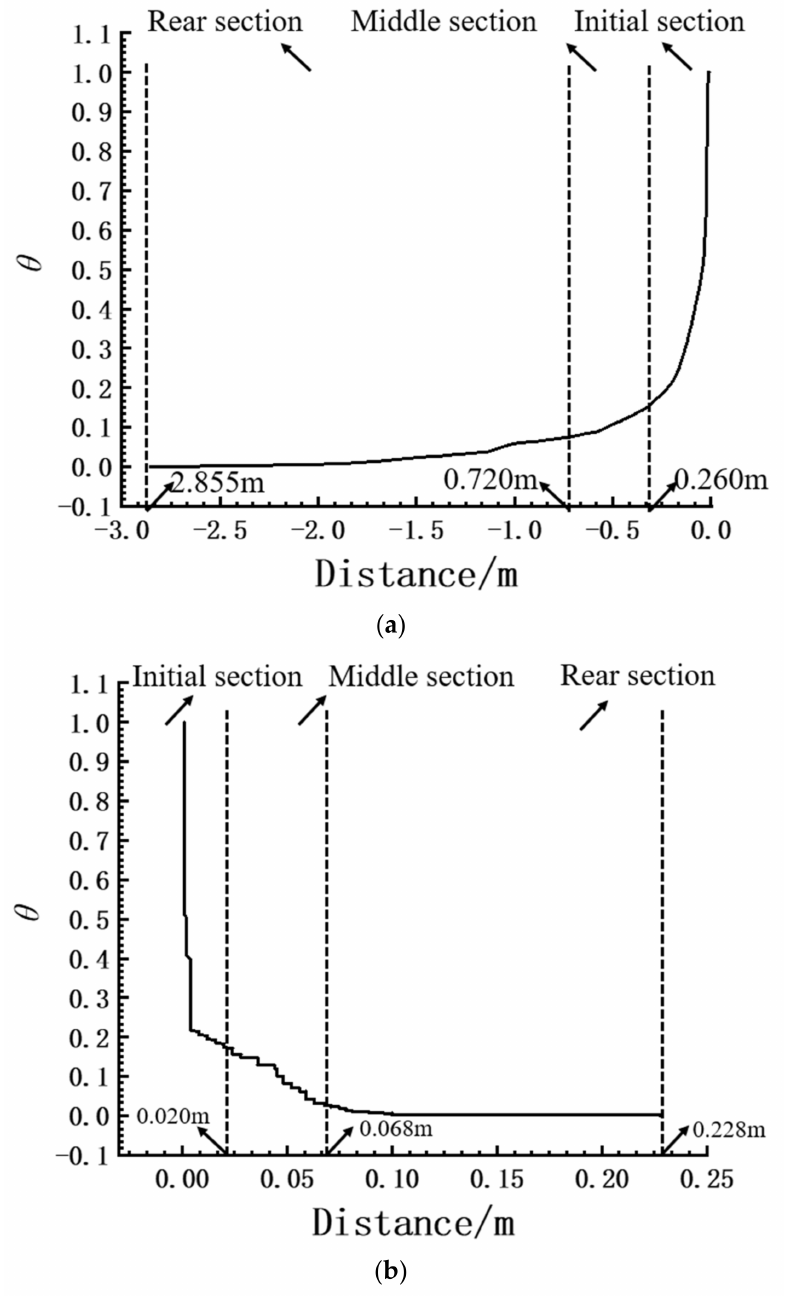
Figure 6. Temperature attenuation indicatrix of the thermal jet from the circle discharge port: ( a ) X-Axis; ( b )